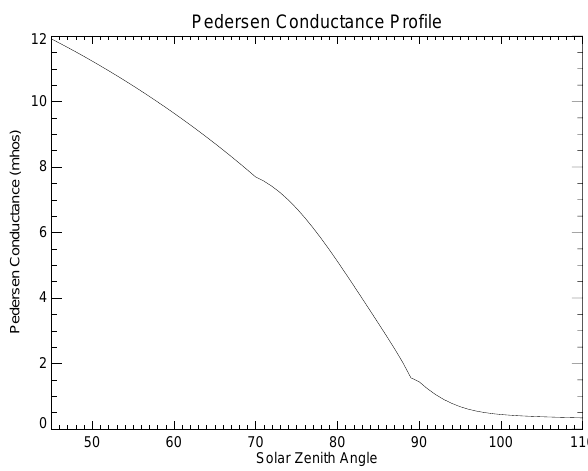
Fig. 2. A plot of the Pedersen conductance as a function of solar zenith angle. This shows the solar driven conductance, a scattering term which causes the conductance to be smoother across the ter- minator, and a nightside constant conductance. The squares of the conductances are added and the square root is taken to derive the total Pedersen